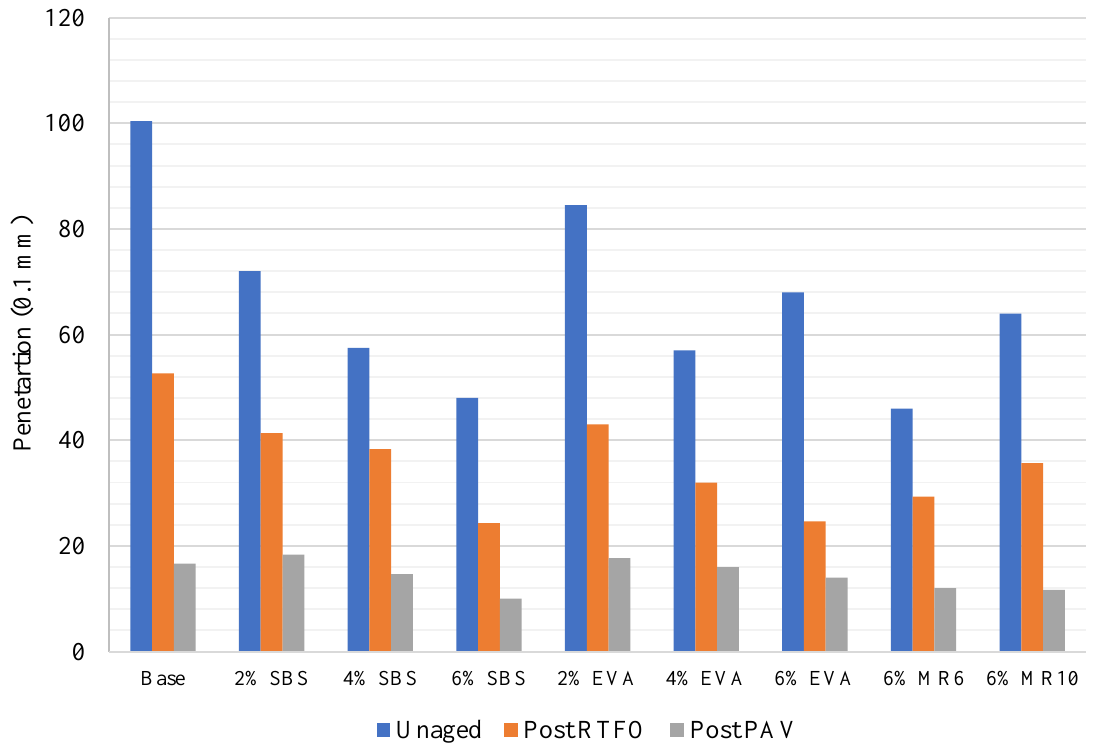
Figure 1. Binder average penetration before and after ageing.